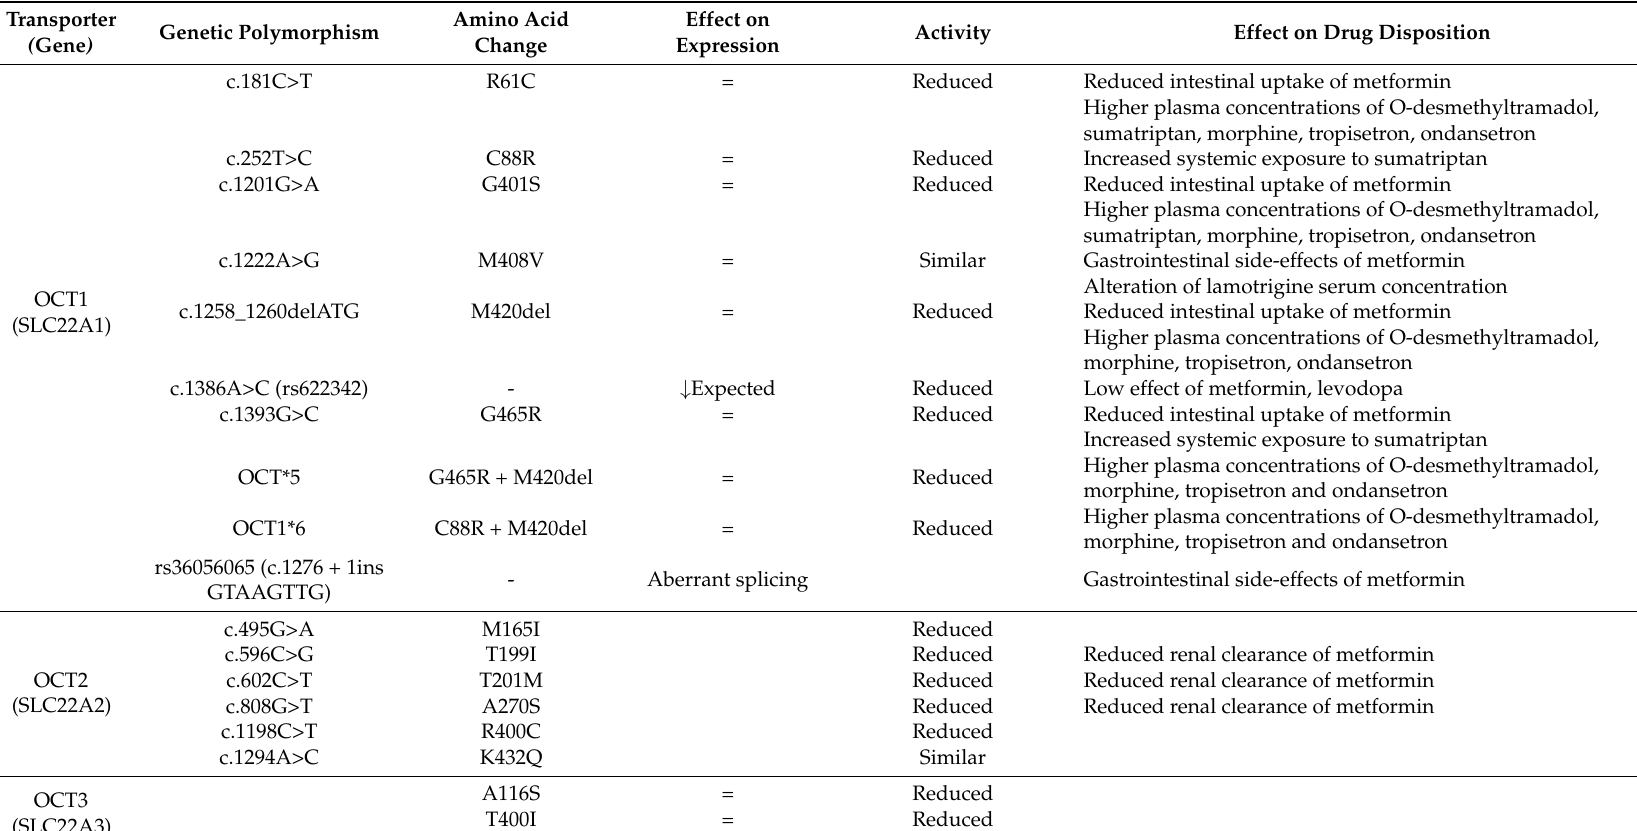
Table 3. Genetic variants in human organic cation transporters of the SLC22A